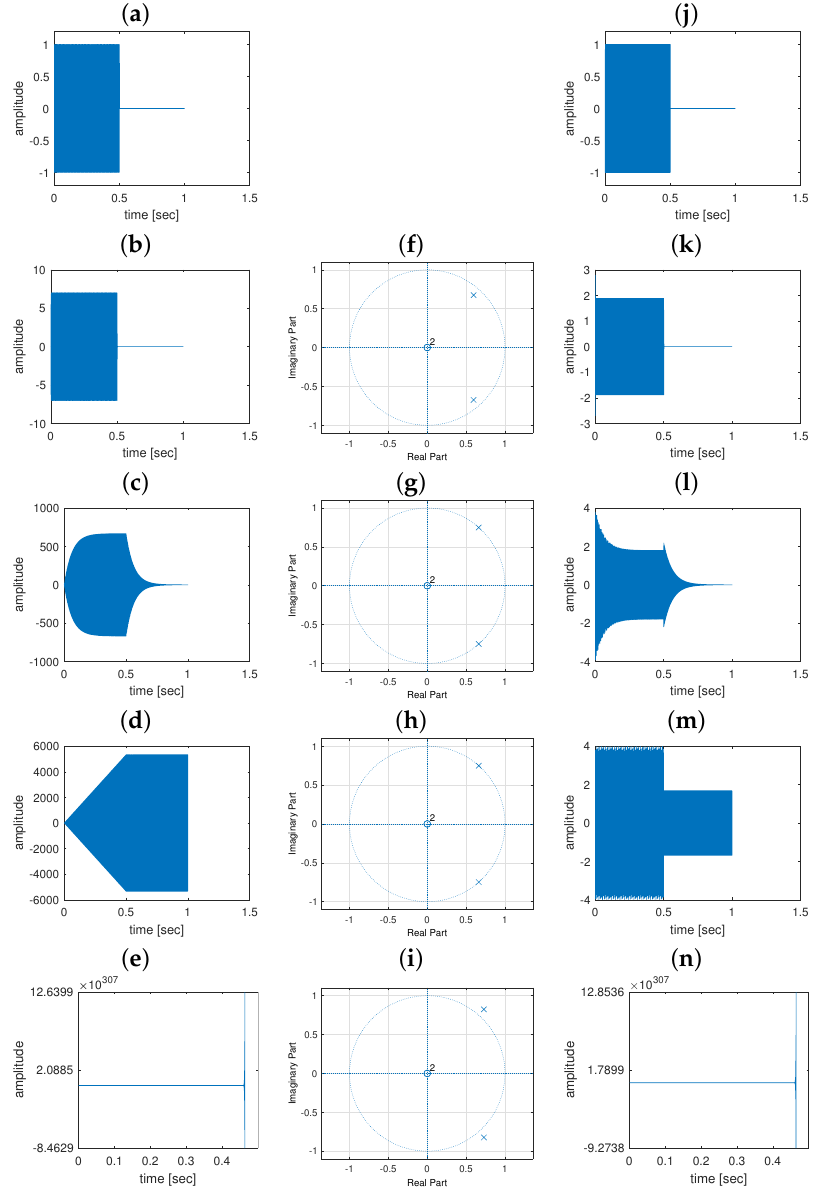
Figure 2. Two-pole system TF response graphs. The two complex conjugate poles of the system TF correspond to a frequency of 2156.25 Hz, while the sampling frequency is 16 kHz. Each row (e.g., b,f,k ) corresponds to a pair of conjugate poles with a magnitude in depicts the input signals, and the other rows show the output signals for each of the resulting TFs. Two sinusoidal input signals are tested: the left column ( a – e ) refers to a frequency of 2156.25 Hz, and the right column ( j – n ) refers to a frequency of 3000 Hz. The middle column ( f – i ) depicts the pole-zero graphs of each